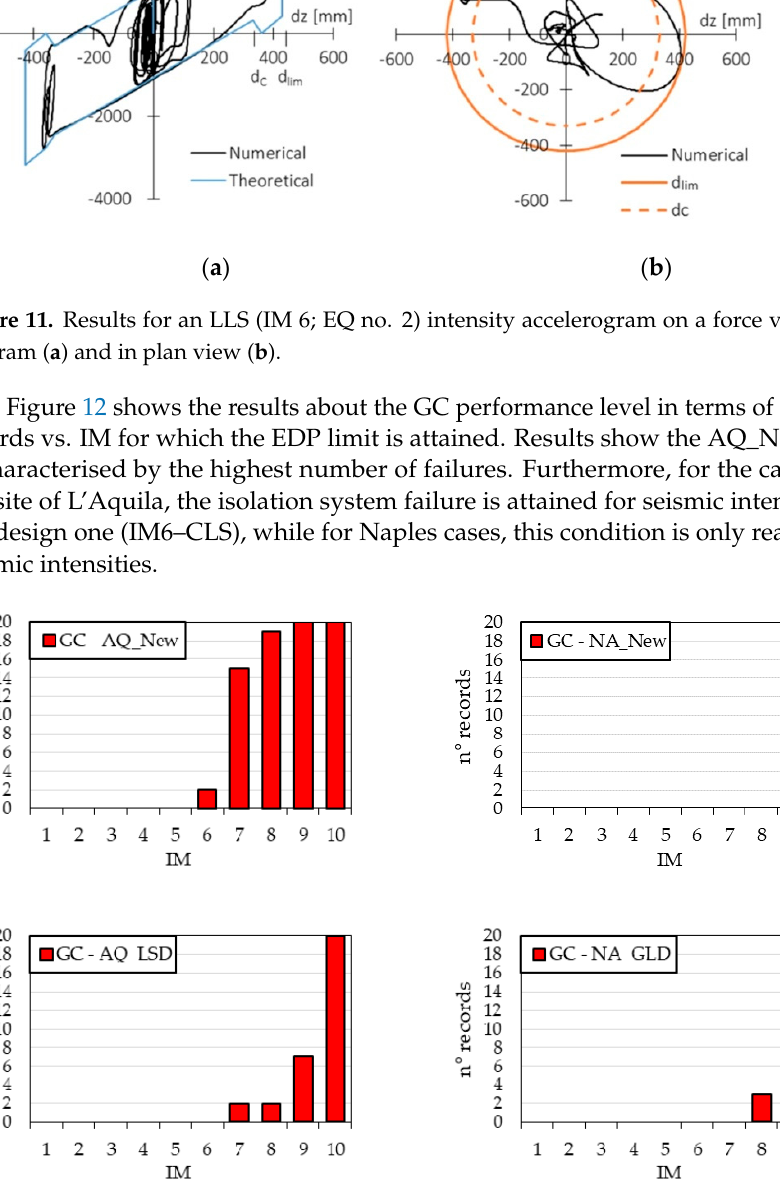
Figure 12. GC results for the four case studies analysed.